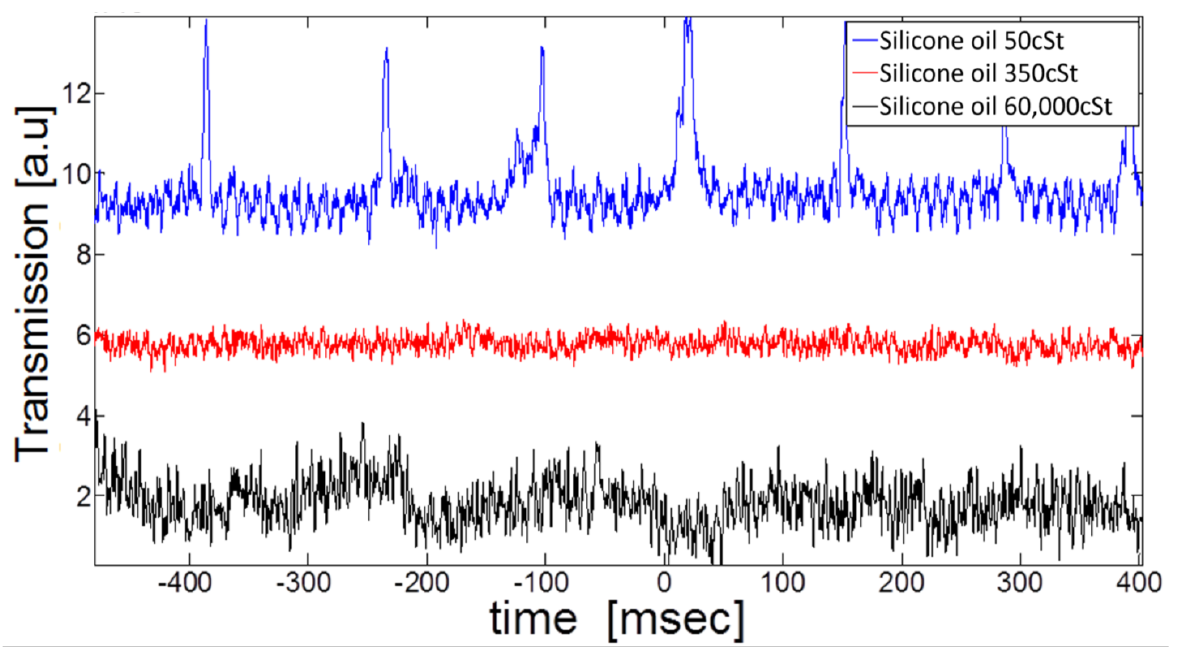
Figure 6. Resonator characterization. (left) Modes as detected by a photodiode. (right) Higher-order transverse modes as detected by a camera.